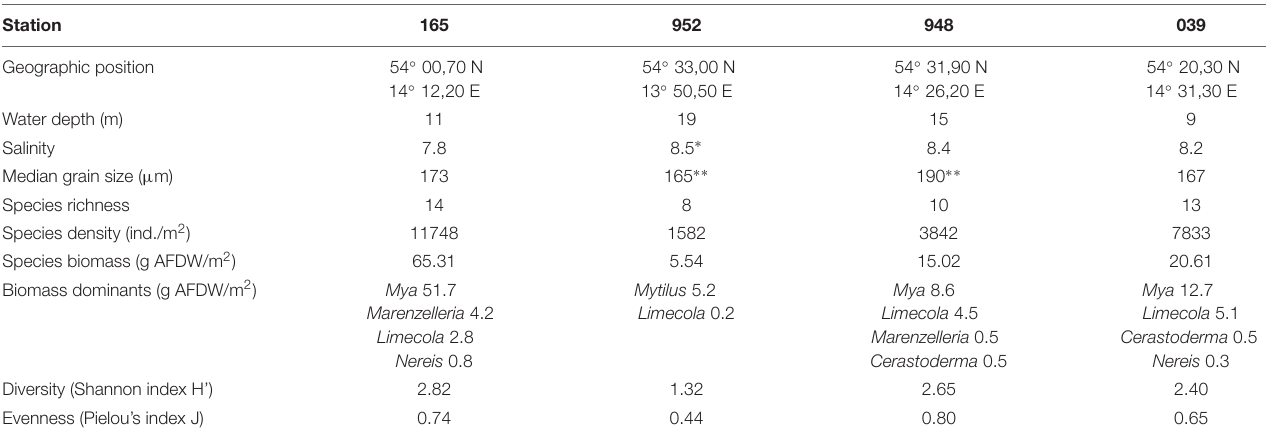
FIGURE 1 | Map of the investigation area, Pomeranian Bay, and its location in the southern Baltic Sea. Stations are located at different water depths between 9 and 19 m across the shallow bay consisting of well sorted fine sands. The deeper channel system with more heterogeneous and considerably finer sediment is not part of the sampling scheme. TABLE 1 | Abiotic and biotic characteristics of the four stations in Pomeranian